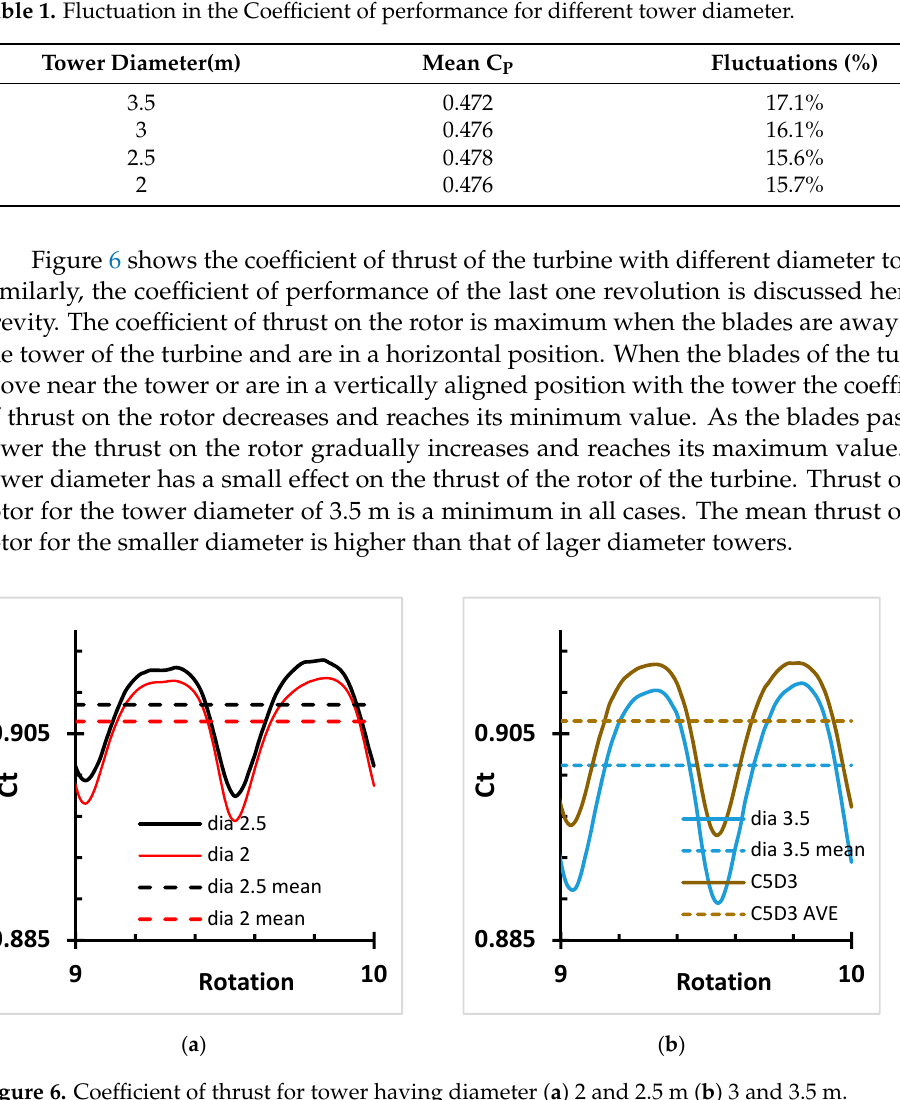
Table 1. Fluctuation in the Coefficient of performance for different tower diameter.